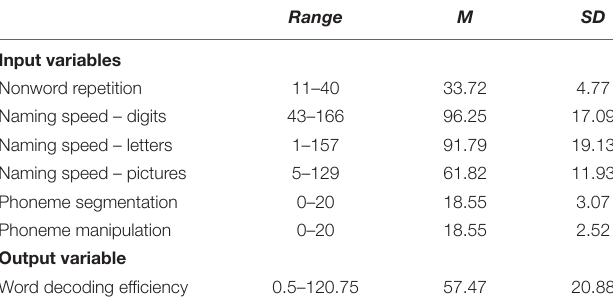
TABLE 3 | Descriptive statistics for input variables and output variable of the models ( n =